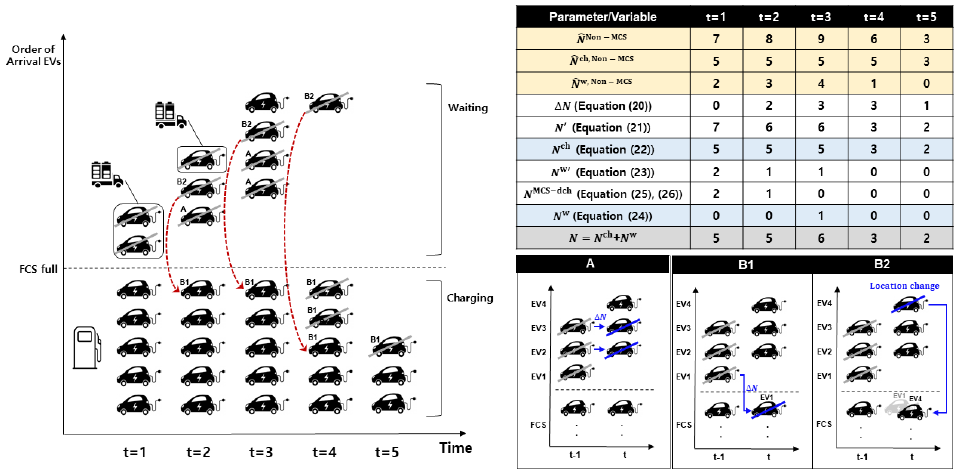
Figure 3. Example illustrating electric vehicle (EV) queue dynamics at fixed charging station